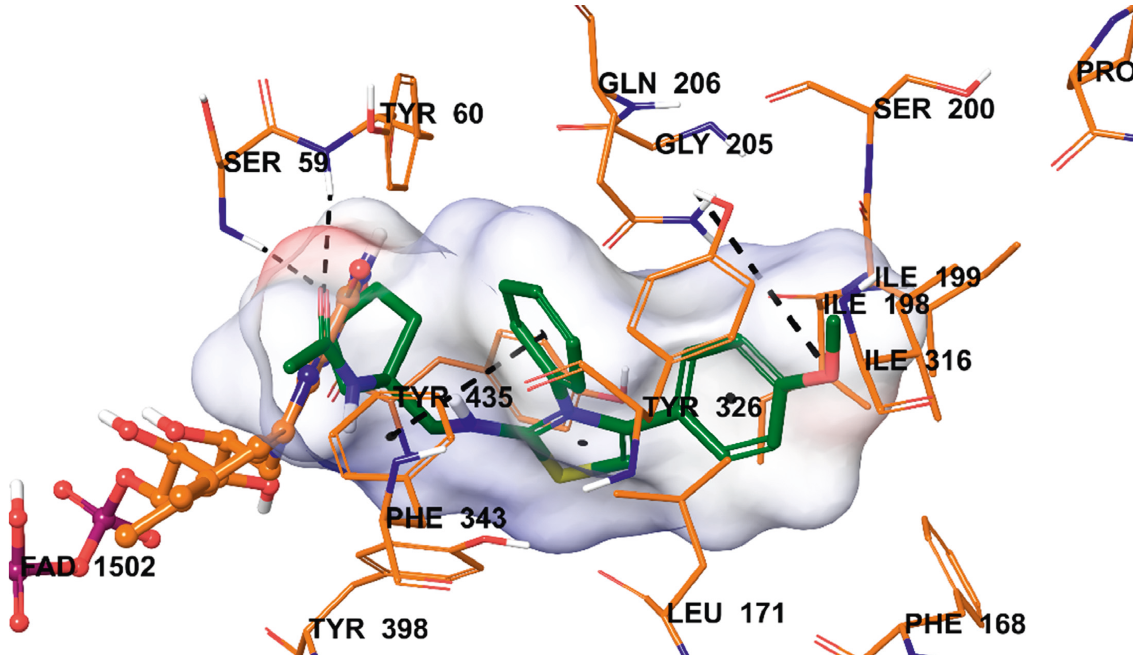
Figure 4: Docking studies including interacting modes of compound 4b in the active region of h MAO-B. The inhibitor and the important residues in the active site of the enzyme are presented by tube model. The FAD molecule is colored orange with ball and stick